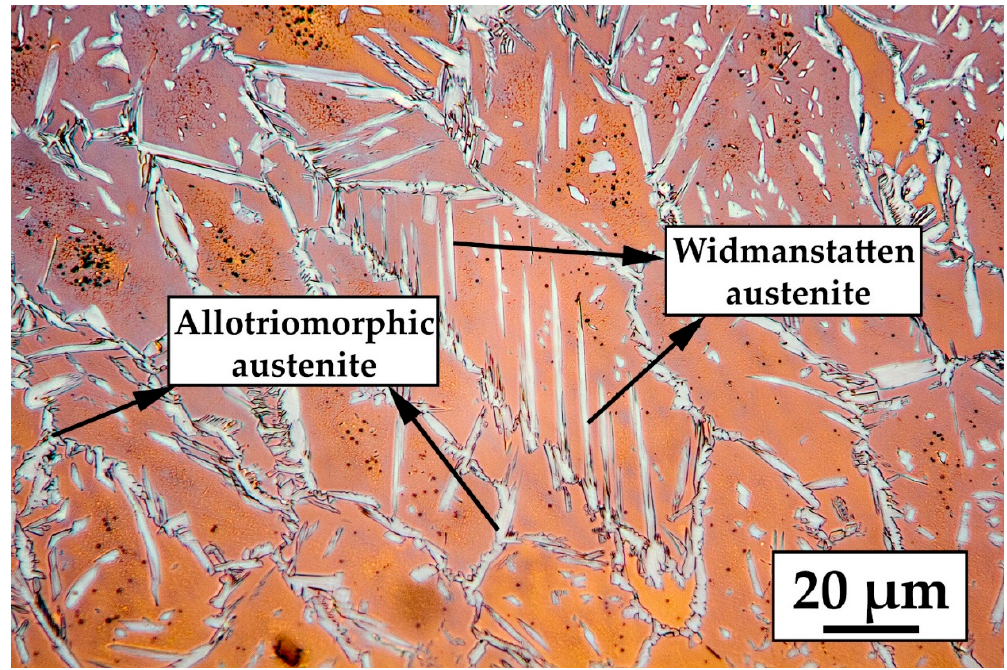
Figure 5. Microstructure of the welded zone showing austenite (light phase) and ferrite (brown